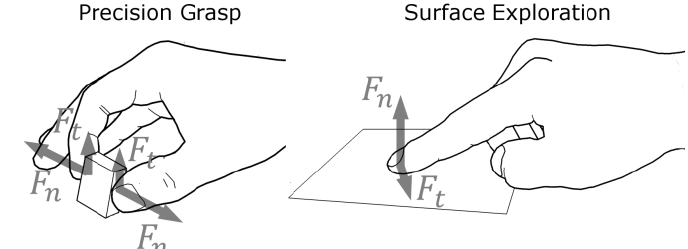
Figure 1. Illustration of the two types of direct finger interaction that are considered for the development of the force sensor. Precision Grasp refers to the grasping of small objects between thumb and index finger while Surface Exploration refers to the stroking of the finger on a surface to explore its